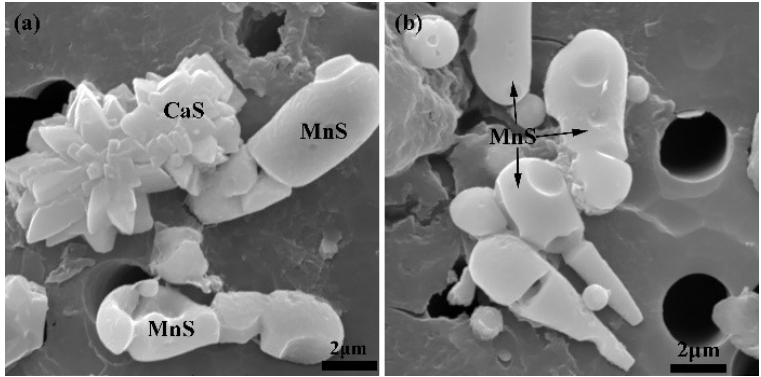
Figure 10. Sulfide inclusions at high S content. ( a ) [S%] = 0.007; ( b ) [S%] = 0.017.